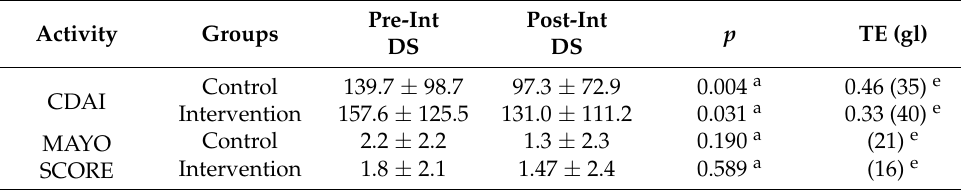
Table 3. Effectiveness of the group psychological intervention program on disease activity. Activity Groups